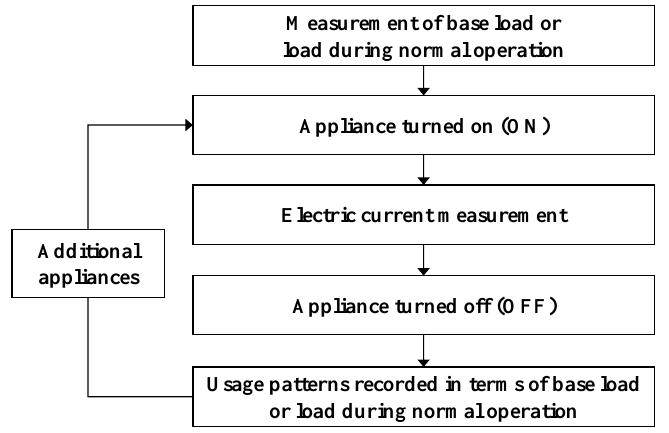
Figure 3. Measurement Plan.